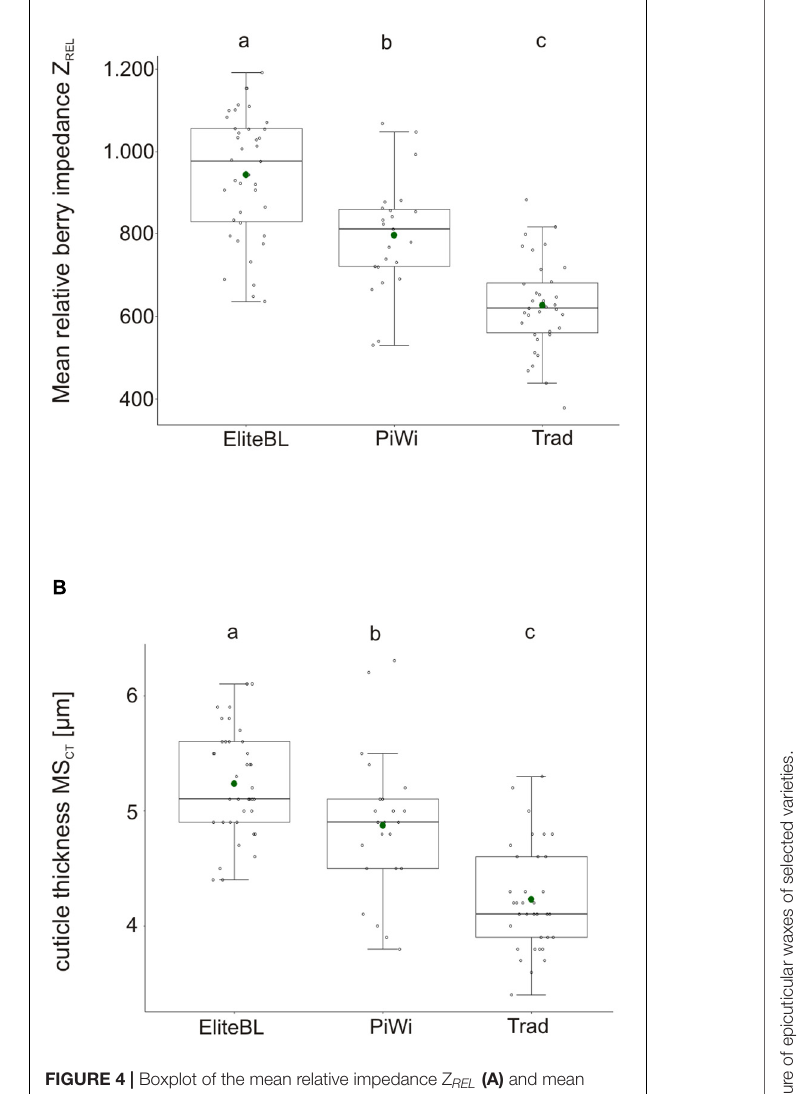
FIGURE 4 | Boxplot of the mean relative impedance Z REL (A) and mean cuticle thickness MS CT (B) in elite breeding lines (Elite BL), PiWi (fungus-resistant varieties), and traditional varieties (Trad). Different letters indicate significant differences. N = 39 (Elite BL), N = 35 (Trad), and N = 23 (PiWis). Detailed information about investigated accessions is given in Supplementary Table 8